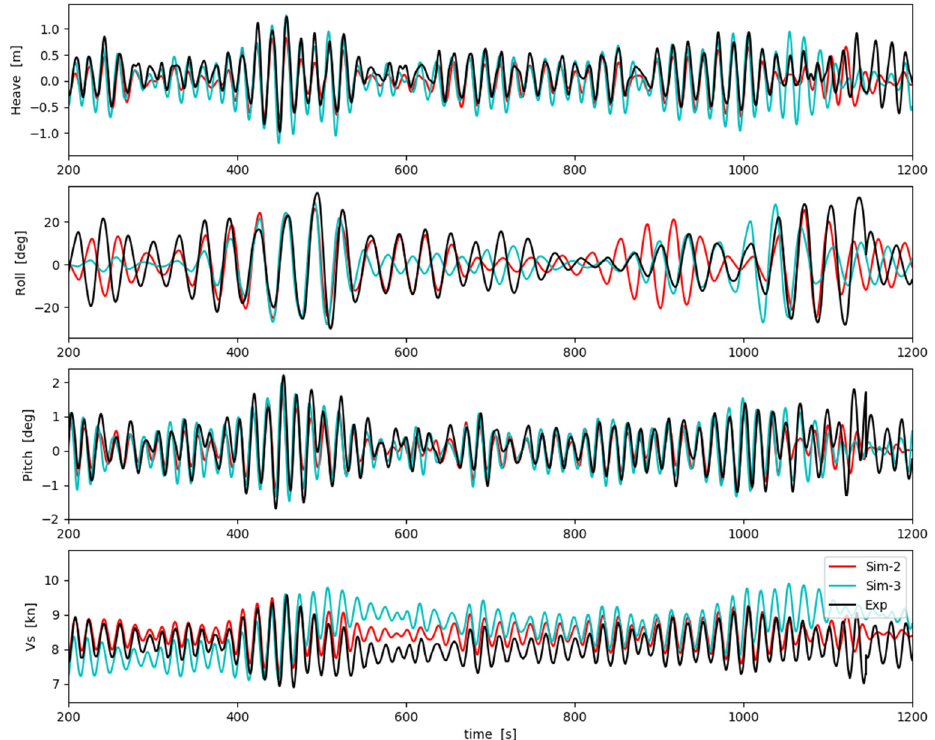
Figure 13. Results of the second case of a deterministic comparison of a parametric roll event in irregular following seas (Jonswap spectrum, Hs = 4.0 m, Tp = 13.5 s, γ = 3.3), vs. ≈ 8 kn.